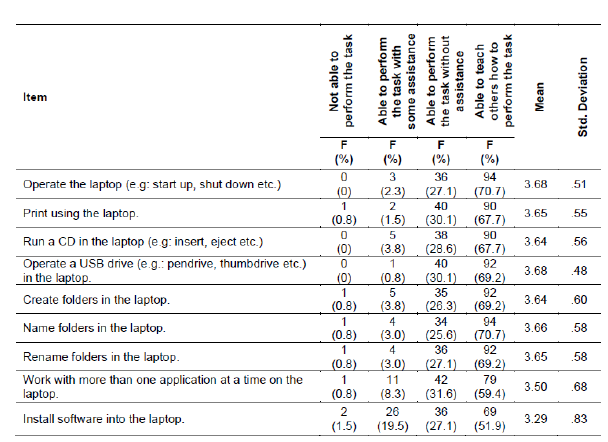
Table 4. Descriptive Statistics for Items on